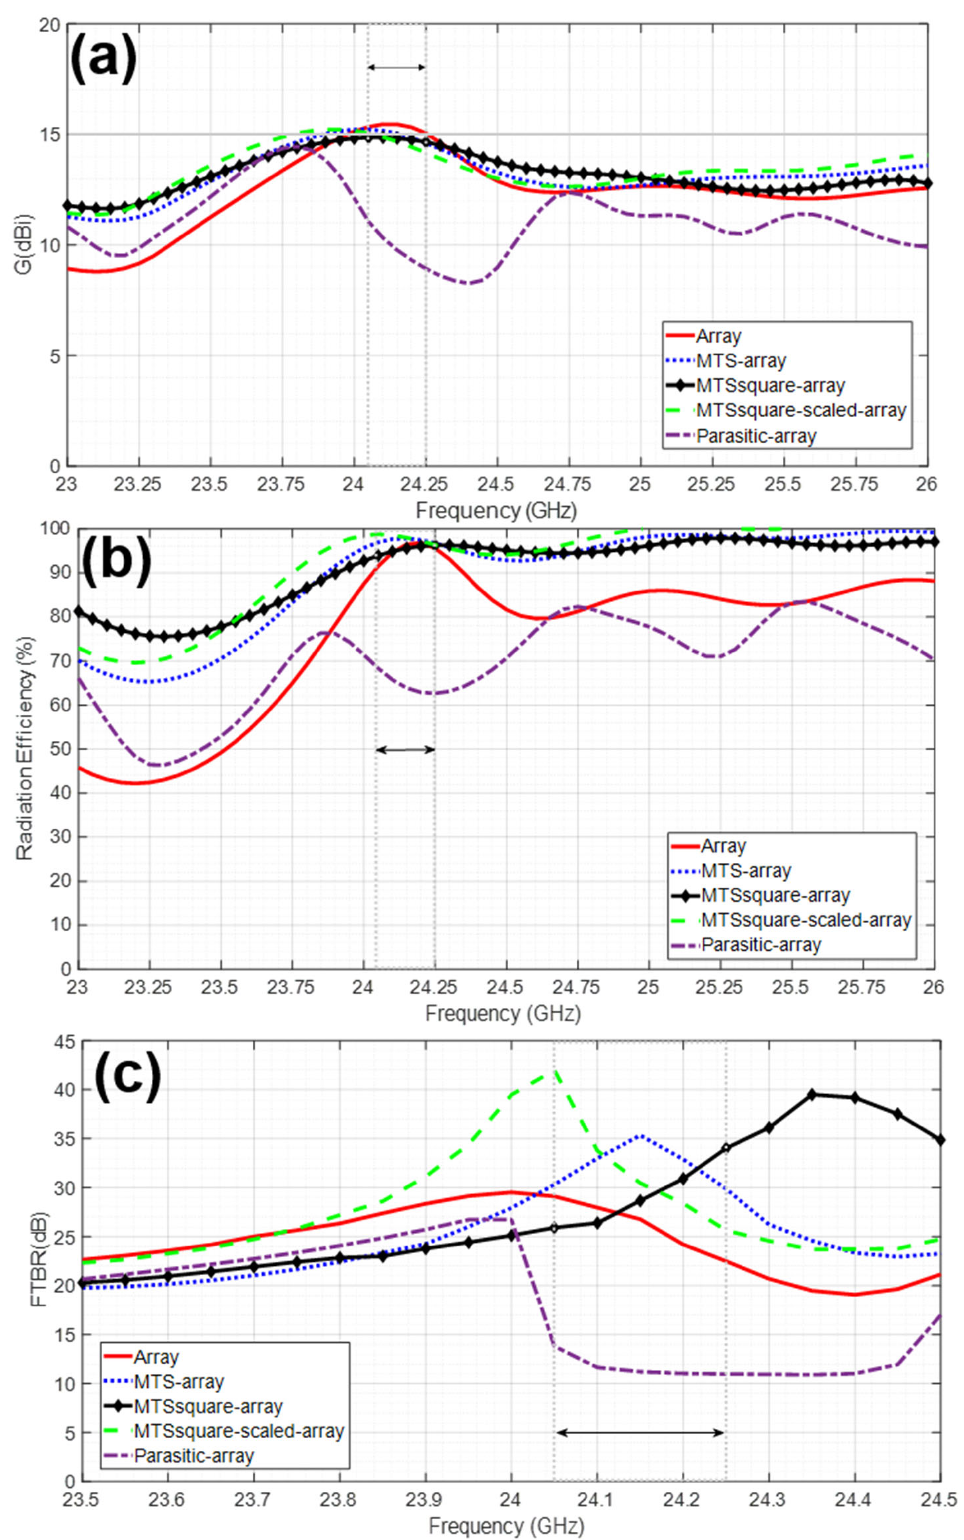
Figure 6. Simulation results for ( a ) gain (dBi), ( b ) radiation efficiency (%) and ( c ) front-to-back ratio FTBR (dB) for the antennas under analysis.